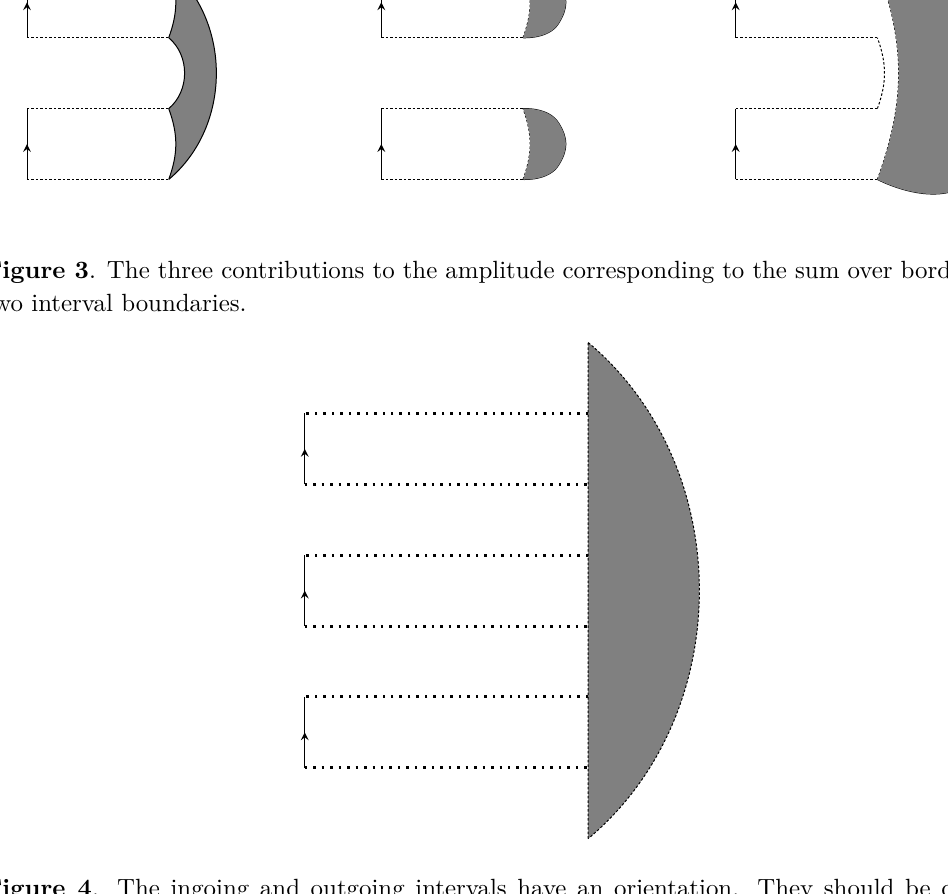
Figure 4 . The ingoing and outgoing intervals have an orientation. They should be considered one-morphisms in a two-category between objects of that two-category, while the two-dimensional surface is a two-morphism between one-morphisms. The dashed lines inherit an orientation and carry a boundary condition associated with the end of the ingoing (or outgoing) interval. The dashed lines with the same boundary condition must be connected up, leading to symmetric group combinatorics when evaluating the